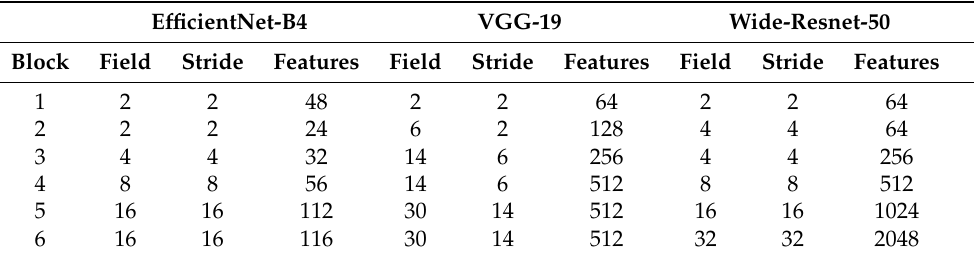
Table 2. The minimal patch size R , the internal stride and number of features for different feature blocks of the analyzed convolutional neural networks (CNNs). Note the significantly larger re- ceptive field of the VGG-19 for deeper blocks that simplifies detecting global novelties while the EfficientNet-B4 with its smaller receptive field and larger non-overlapping strides can focus on locally concentrated novelty. EfficientNet-B4 VGG-19 Wide-Resnet-50 Block